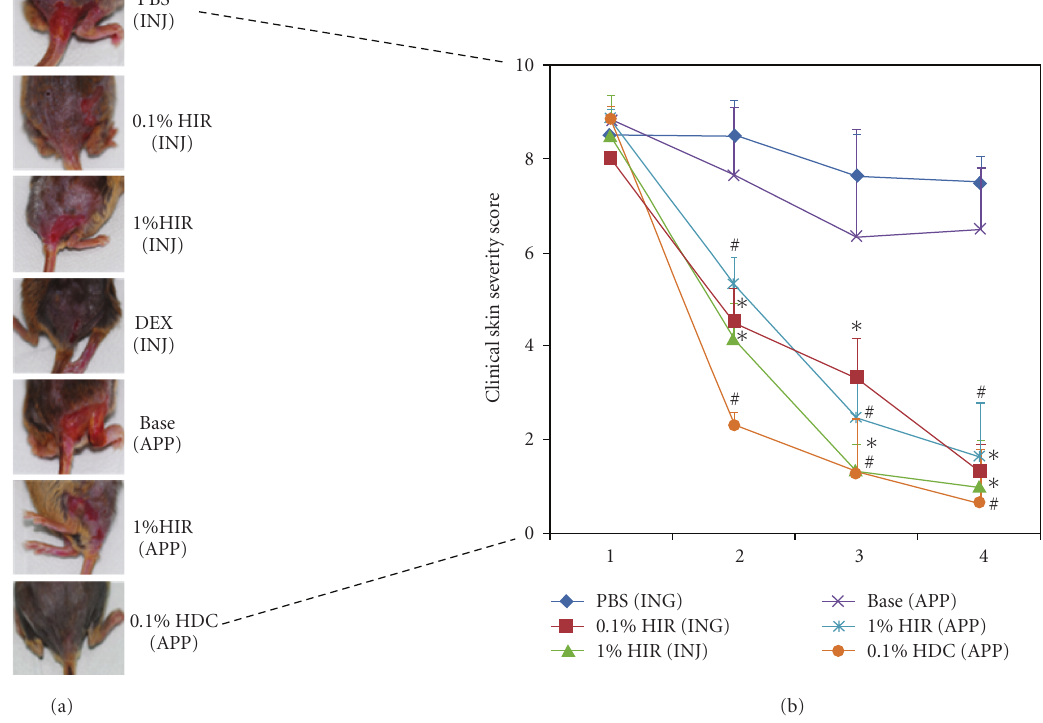
Figure 2: Progression of clinical dermatitis score for di ff erent intervention groups during the 4 weeks treatment period. Clinical findings were scored at 1-week intervals. (a) Representative clinical feature of NC/Nga mice skin. (b) HIR treatment significantly lowered total clinical severity scores. Data shown are mean ± S.D. of changes in total clinical dermatitis scores for face, ears, nose, and back. HIR: Hirsutenone, DEX: dexamethasone, Base: Baseline, HDC: hydrocortisone cream, INJ: injection, APP: application. ∗ P < .05 compared with the PBS group. # P < .05 compared with the Base group. n =